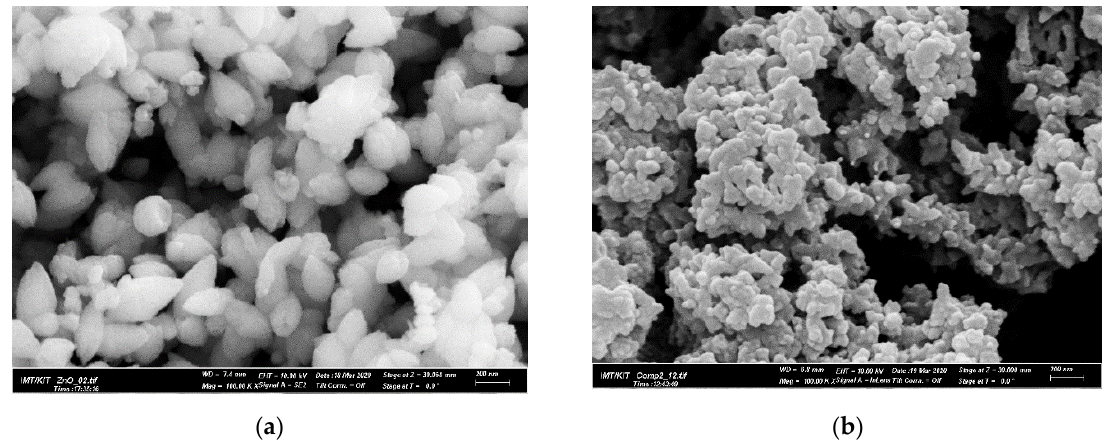
Figure 2. SEM images of ZnO nanoparticles ( a ) and PANI/ZnO nanocomposite ( b ).